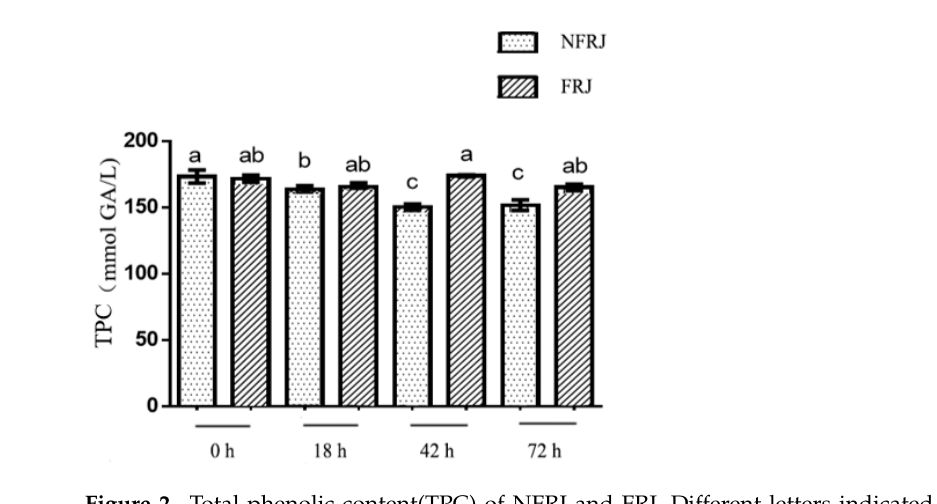
Figure 2. Total phenolic content(TPC) of NFRJ and FRJ. Different letters indicated significantly different at p < 0.05.